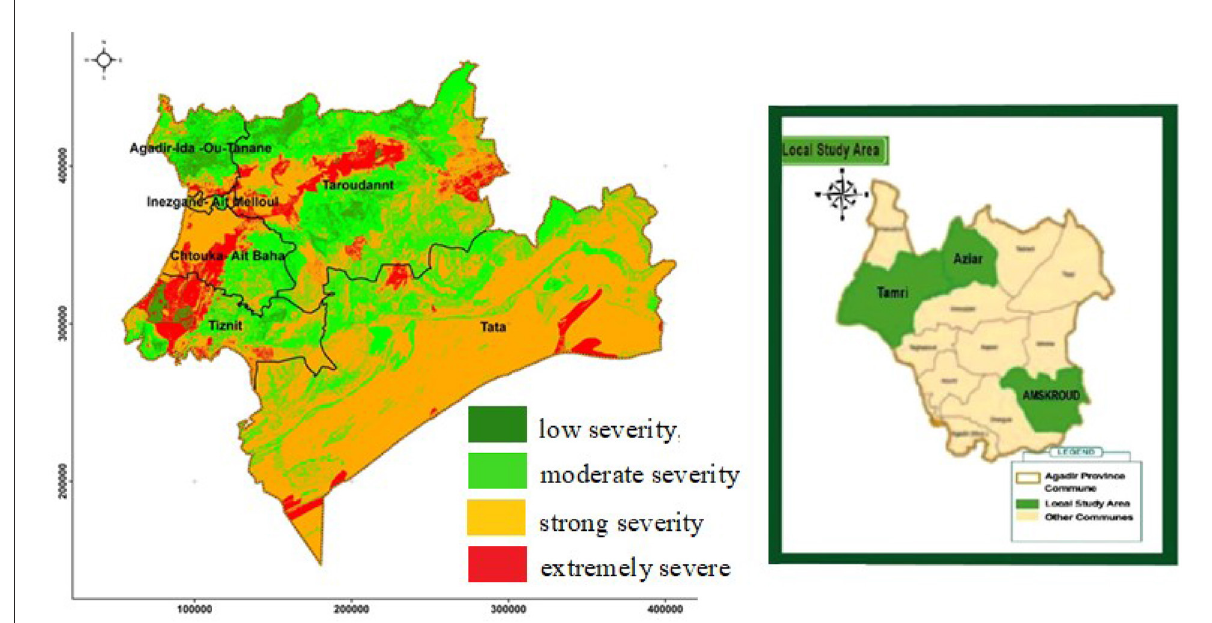
FIGURE3 Map showing the three pilot areas/communes within the Agadir-Ida Outanane province for the participatory land resources planning process with the degree of severity of land